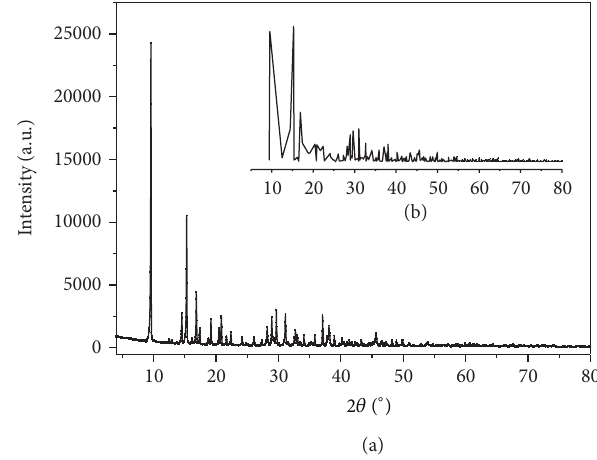
Figure 2: Crystal packing diagram of the title complex.